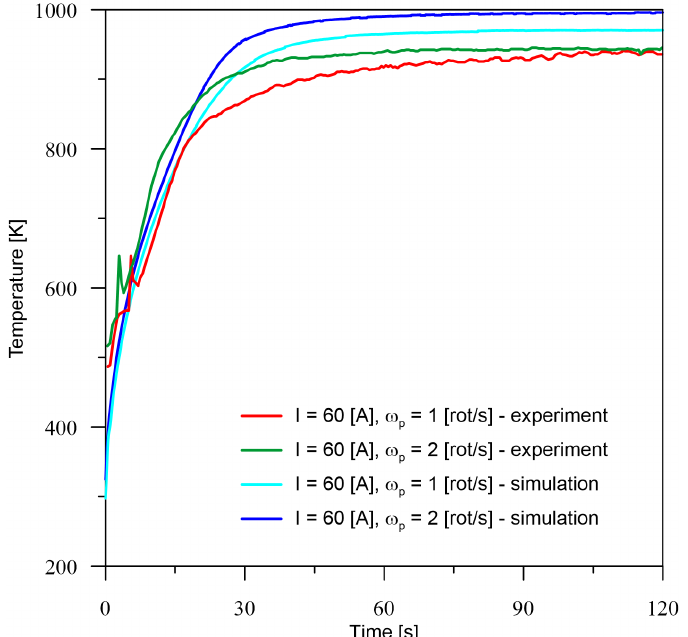
Figure 5. Comparison of the results of the experiment and the numerical model for I = 60 A.